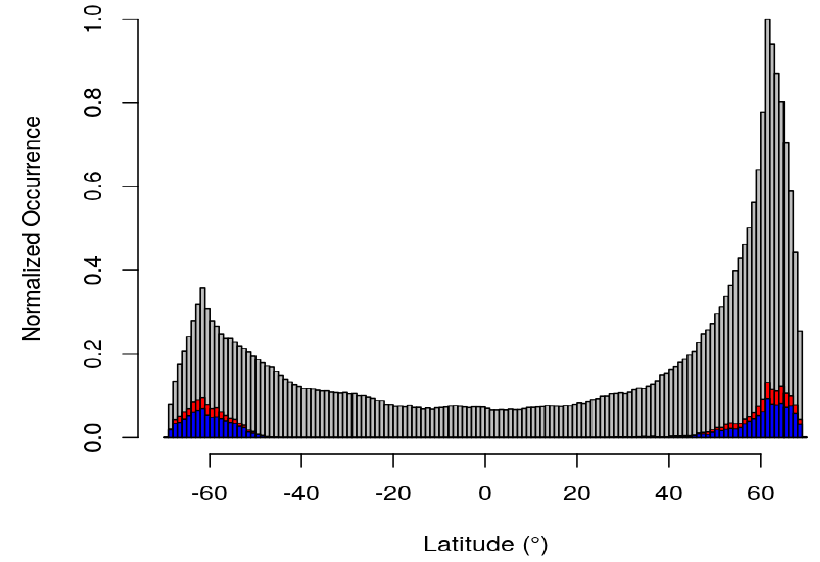
Figure 2. Zonal distribution of GMI/CPR coincidences: All (grey), snowfall (red), and snowfall with supercooled droplets (blue).